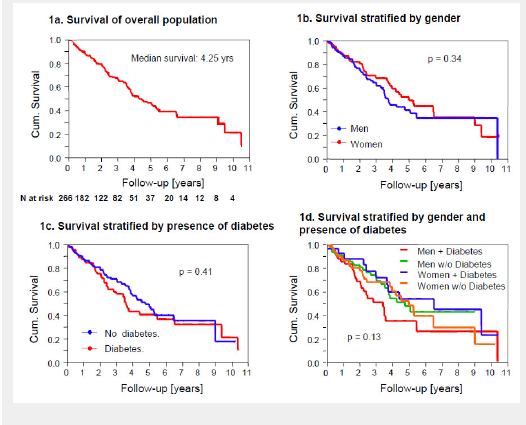
Overall survival on chronic haemodialysis (1a); survival stratified by gender (1b); survival stratified by presence of diabetes (1c); survival stratified by gender and presence of diabetes